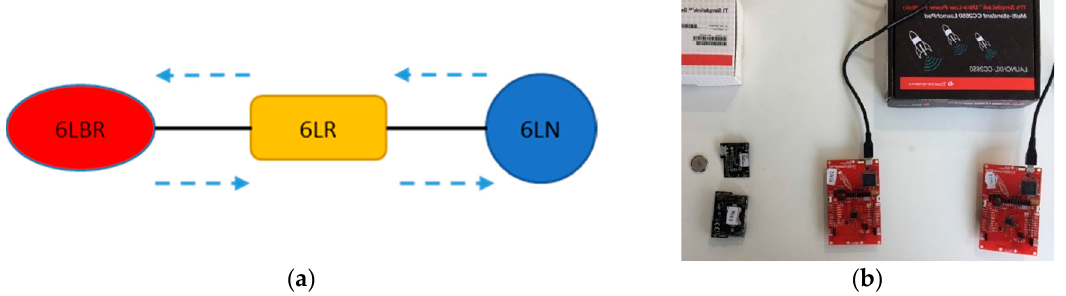
Figure 3. Prototype testbed of the 6BLEMesh implementation: ( a ) the topology; ( b ) device platforms.